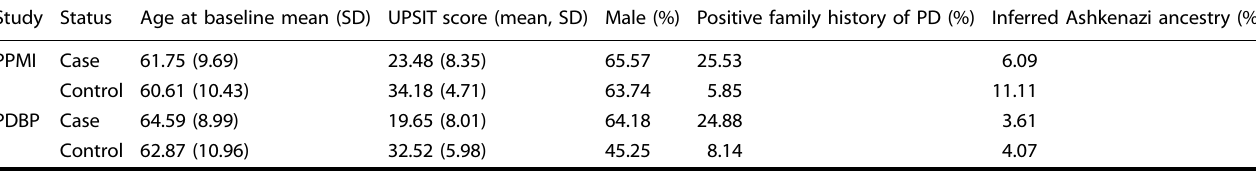
Table 1. Descriptive statistics of studies included from AMP